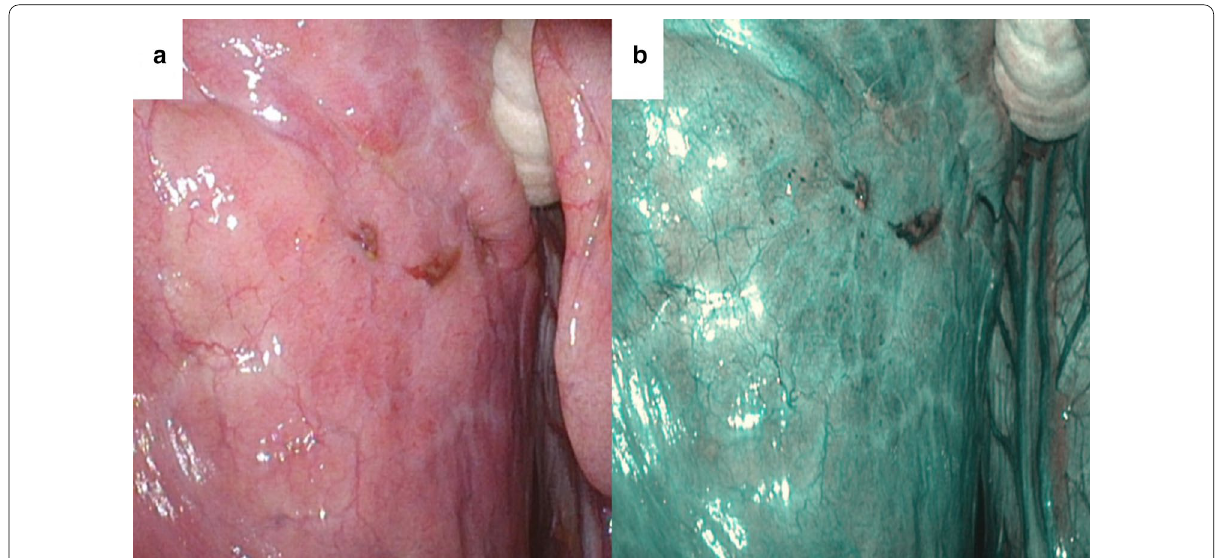
Fig. 2 Representative images of the lung surface in case 2. Brownish spots were visualized as dark green with NBI